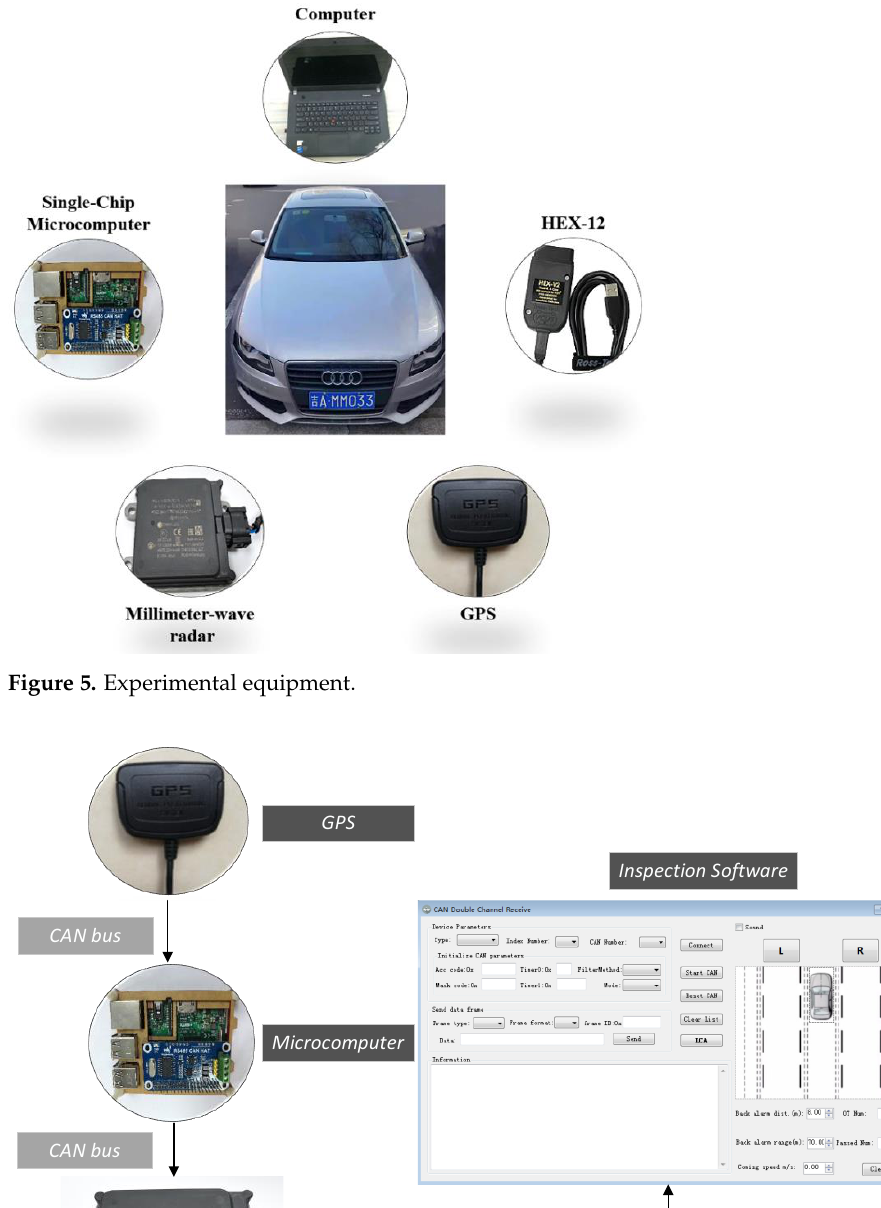
Figure 6. Diagram of millimeter-wave radar and GPS fusion.